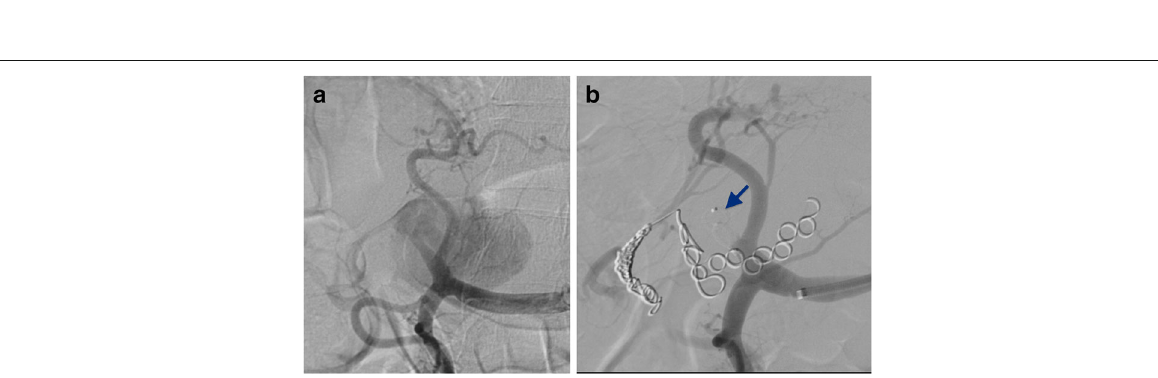
Fig. 2 a Three weeks after pylorus preserving pancreatoduodenectomy, bleeding from the cholecystic arterial stump (arrow) occurred. b Embolization around the cholecystic arterial stump using a 4-mm penumbra occlusion device. The two-way arrow shows the landing distance